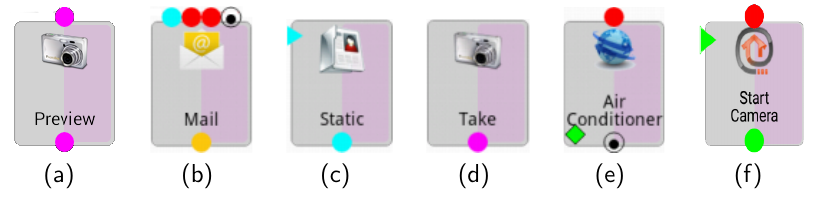
Figure 1. Some MicroApp service